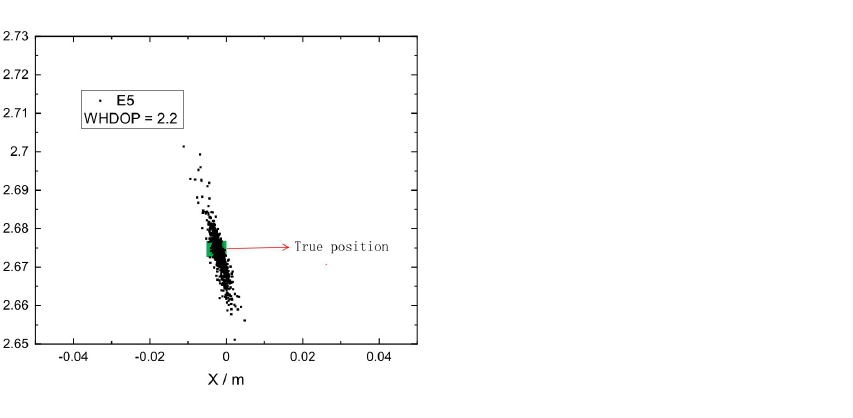
Figure 9. ( top ) The positioning result of the static point A1 (2.6777, 6.059); ( bottom ) the positioning result of the static point E5 (0, 2.6734).